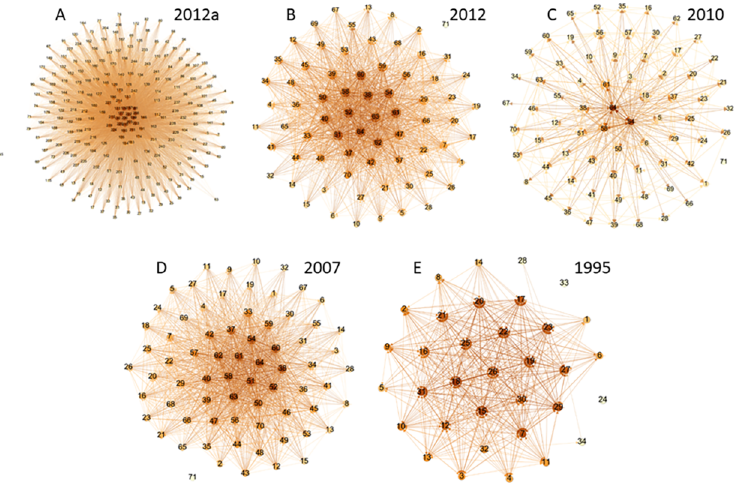
Fig 4. Network evolution of the input-output Ecuadorian matrix. (A) Detailedmatrix 2012, 245 economic sectors. (B) Summary matrix 2012, 71 economicsectors. (C) Matrix 2010, 71 economicsectors. (D) Matrix 2007, 71 economicsectors. (E) Matrix 1995, 34 economicsectors. Each node represents a sector of the economy, and an edge has beenmapped betweentwo nodes when they have a percentage of trade equal to or greater than 1%.